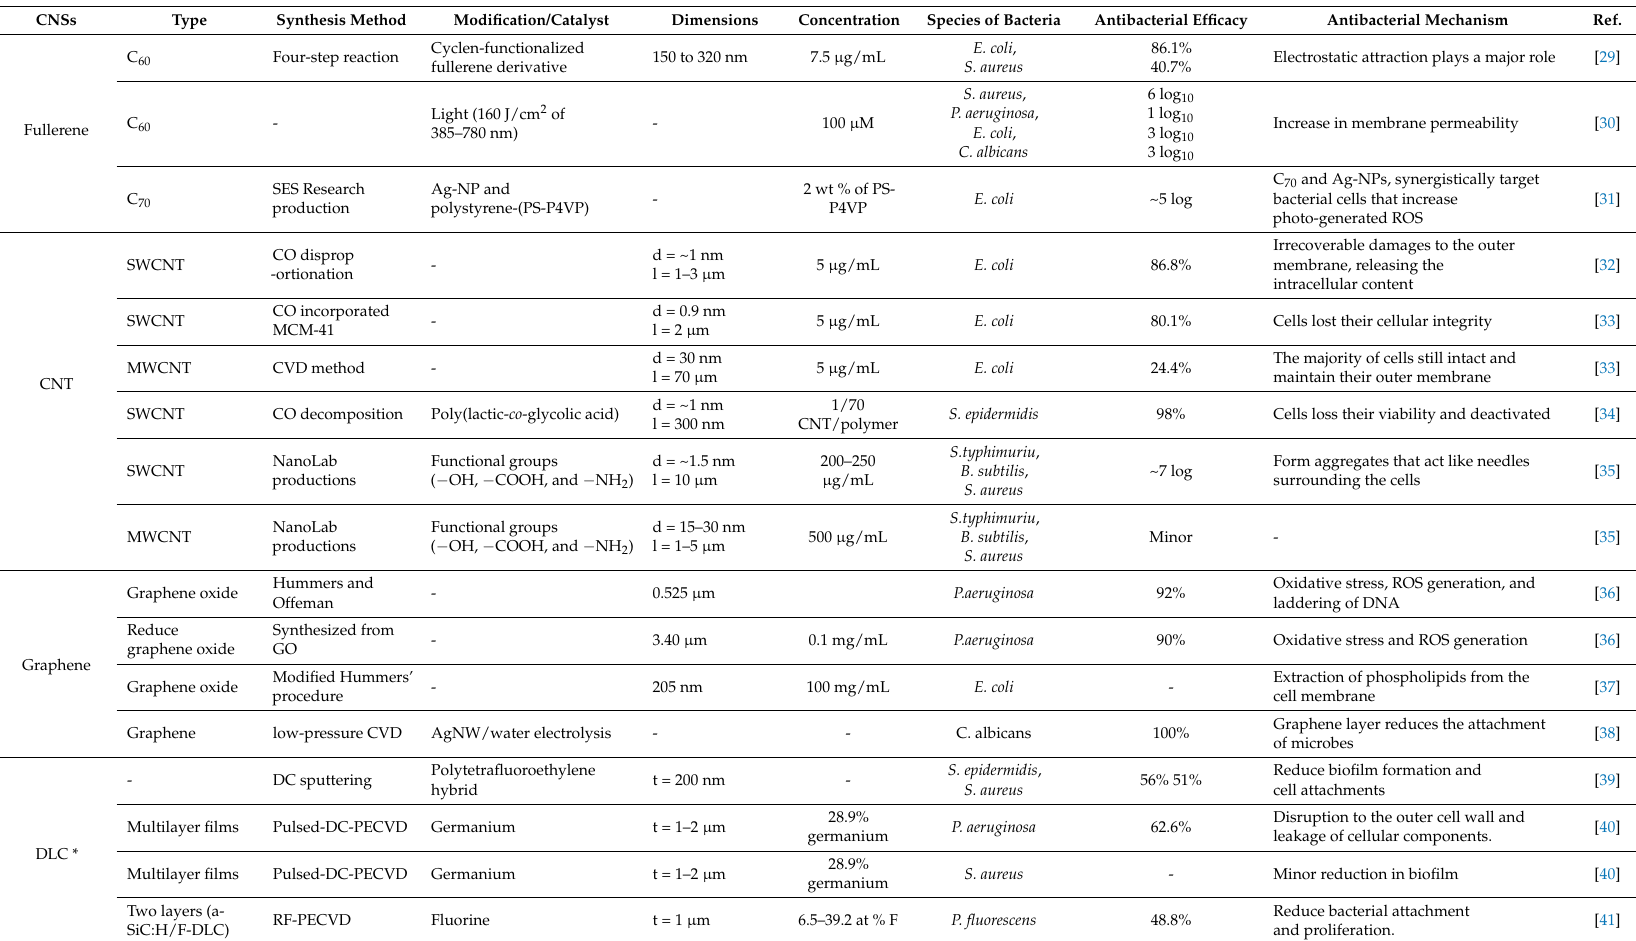
Table 1. The antimicrobial performance of several forms of Carbon nanostructures